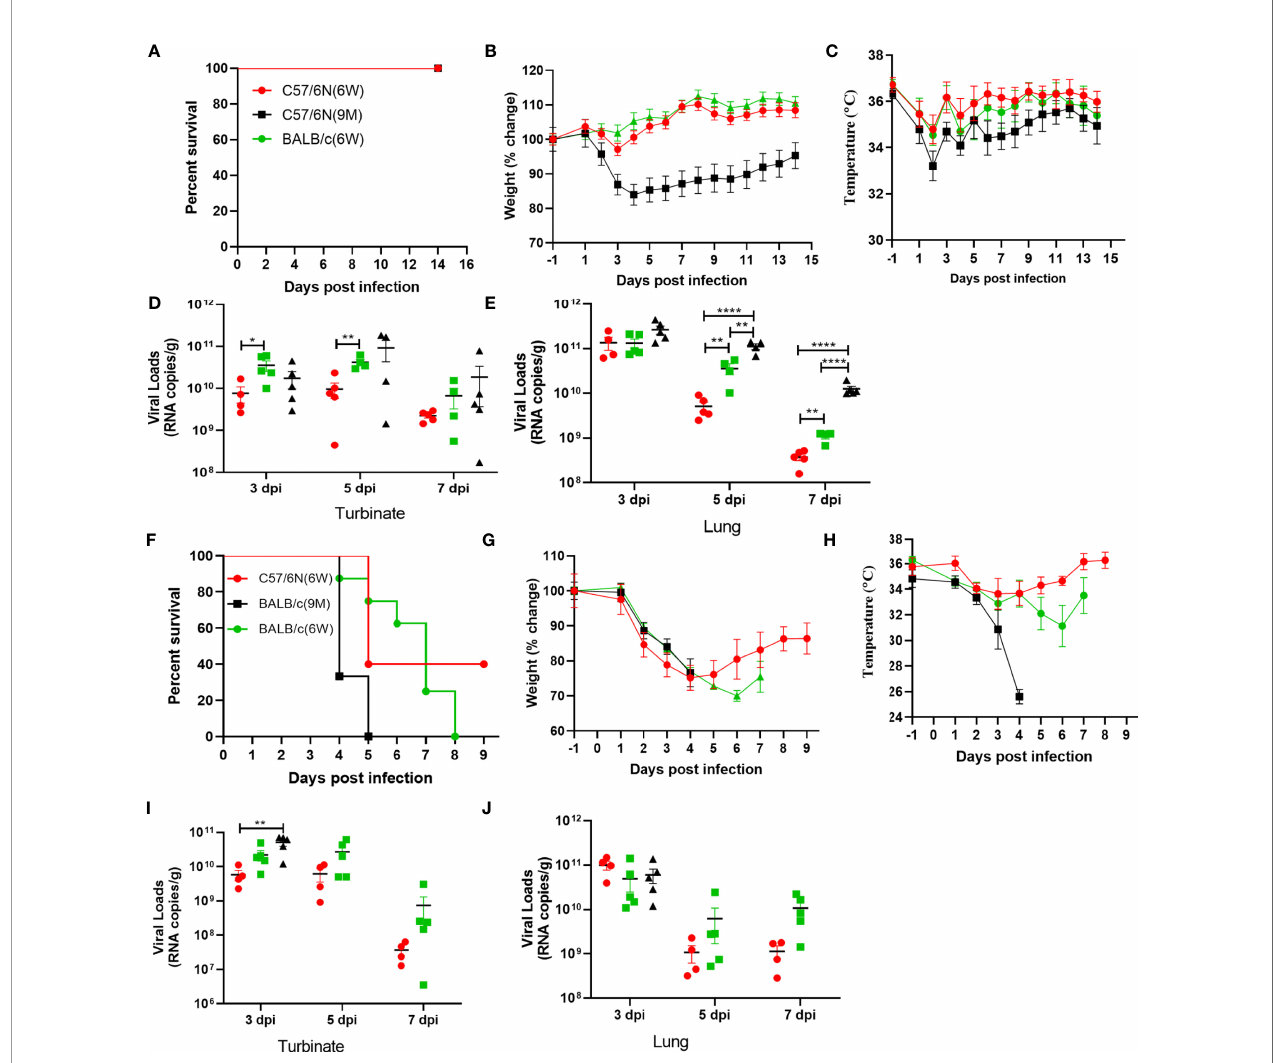
FIGURE 5 | Characterization of age-related and host genetics-dependent mortality and morbidity of severe acute respiratory syndrome 2 (SARS-CoV-2) BMA8 and C57MA14 in mice. To characterize the pathogenesis of SARS-CoV-2 BMA8 associated with age and host genetics, groups of 6-week-old female C57BL/6N mice, 6-week-old female BALB/c mice, and 9-month-old female C57BL/6N mice were infected intranasally with 50 LD 50 of SARS-CoV-2 BMA8 in a volume of 50 µl. The survival rate, weight change, and body temperature in each group (n = 8) were monitored daily after infection (A – C) . At 3, 5, and 7 dpi, fi ve mice of each group were euthanized, and turbinates and lungs were sampled for virus RNA loads by qRT-PCR (D, E) . Similarly, to assess the pathogenesis of SARS-CoV-2 C57MA14, groups of 23 6-week-old female C57BL/6N mice, 6-week-old female BALB/c mice, and 9-month-old female BALB/c mice were infected intranasally with 50 LD 50 of SARS-CoV-2 C57MA14 in a volume of 50 µl. The survival rate, weight change, body temperature, and clinical score in each group (n = 8) were monitored daily after infection (F – H) . At 3, 5, and 7 dpi, fi ve mice of each group were euthanized, and turbinates and lungs were sampled for viral RNA load test by qRT-PCR (I, J) . Data are presented as mean ± SEM. (*P < 0.05, **P < 0.01,****P <